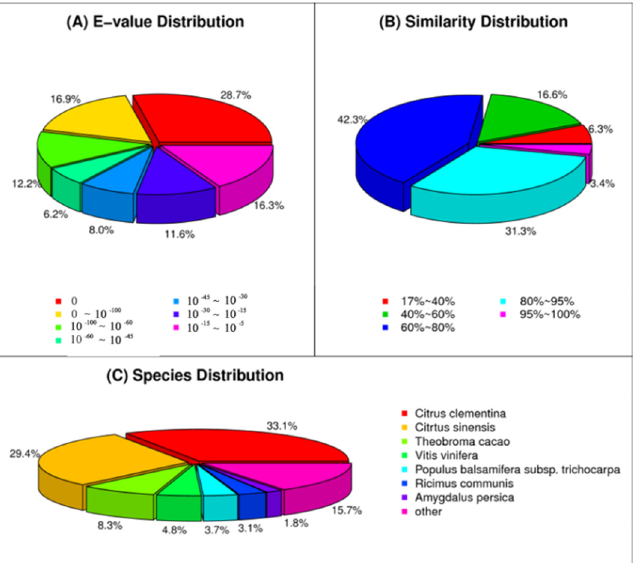
Figure 3. Characterization of the homologous sequences of P. chinensis unigenes blasted against the non-redundant database. ( A ) Frequency distribution of the unigene sequences according to their E values (cut-off value = 1.0 × 10 − 5 ). ( B ) Percentage of the top matched unigene sequences in P. chinensis . ( C ) Species distribution of the matched homologous sequences with an E-value of 1.0 × 10 − 5 .